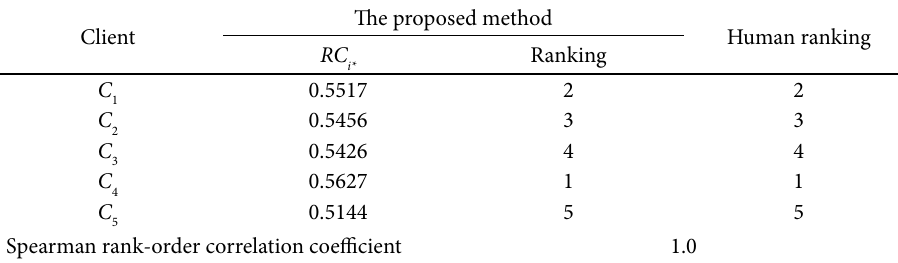
Table 9. Comparison of results between the proposed method and manual ranking for